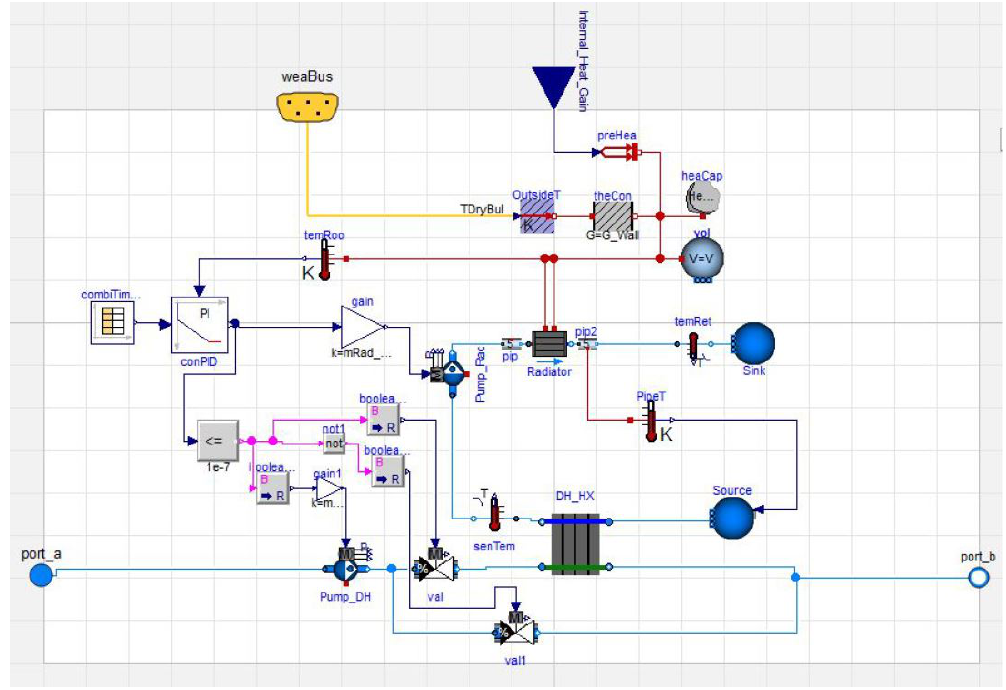
Figure 1. Simulation model for the final user, software: Modelica–Dymola